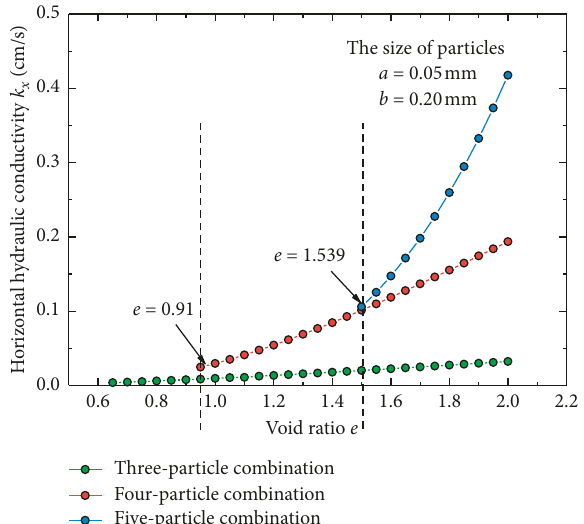
Figure 16: The relationship between hydraulic conductivity and void ratio under different particle combinations.